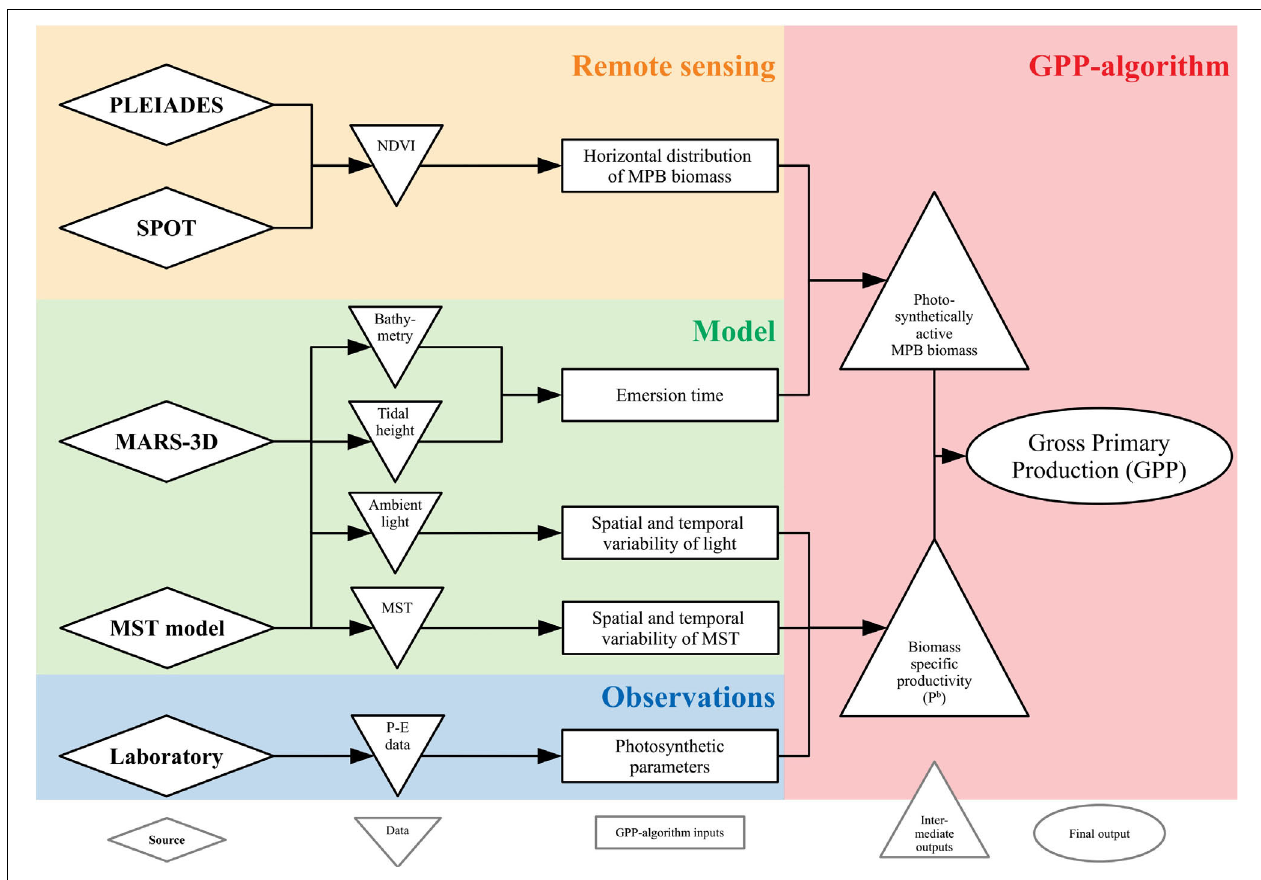
FIGURE 3 | Conceptual scheme of the MPB GPP-algorithm.